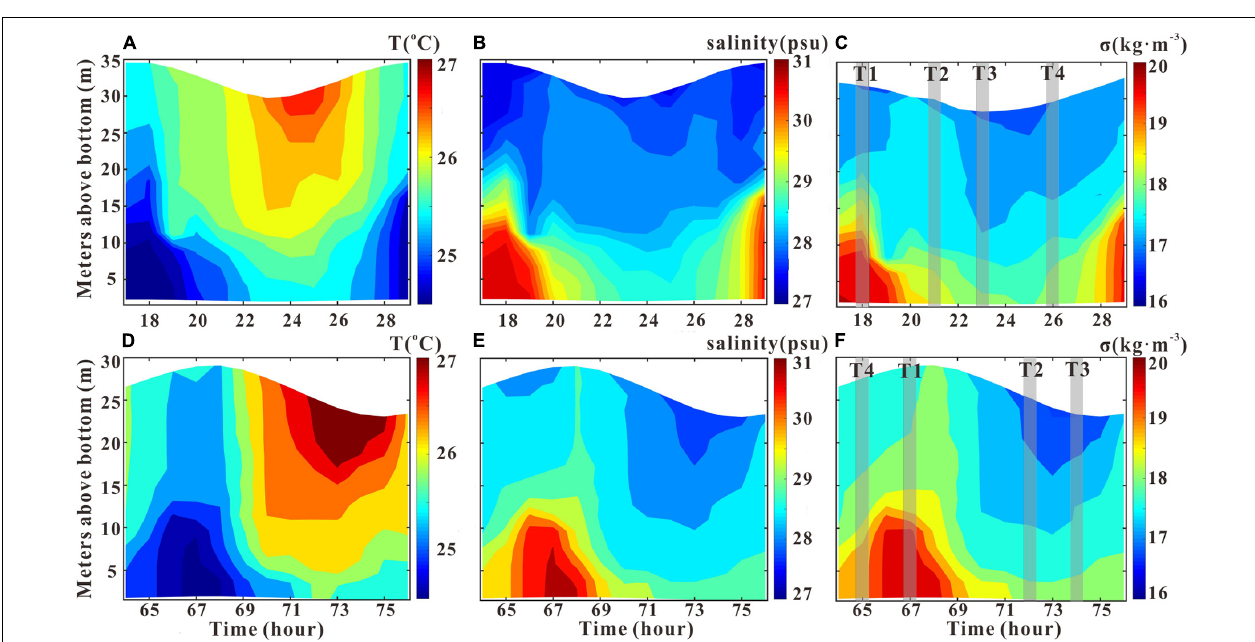
FIGURE 4 | Hourly variations in the vertical structure of temperature, salinity, and density anomaly σ ( ρ -1000) at GJ-01 on July 14, 2019 (A–C) , and those at GJ-02 on July 16, 2019 (D–F) . T1–T4 are the selected periods representing flood slack, maximum ebb, ebb slack, and maximum flood, respectively.